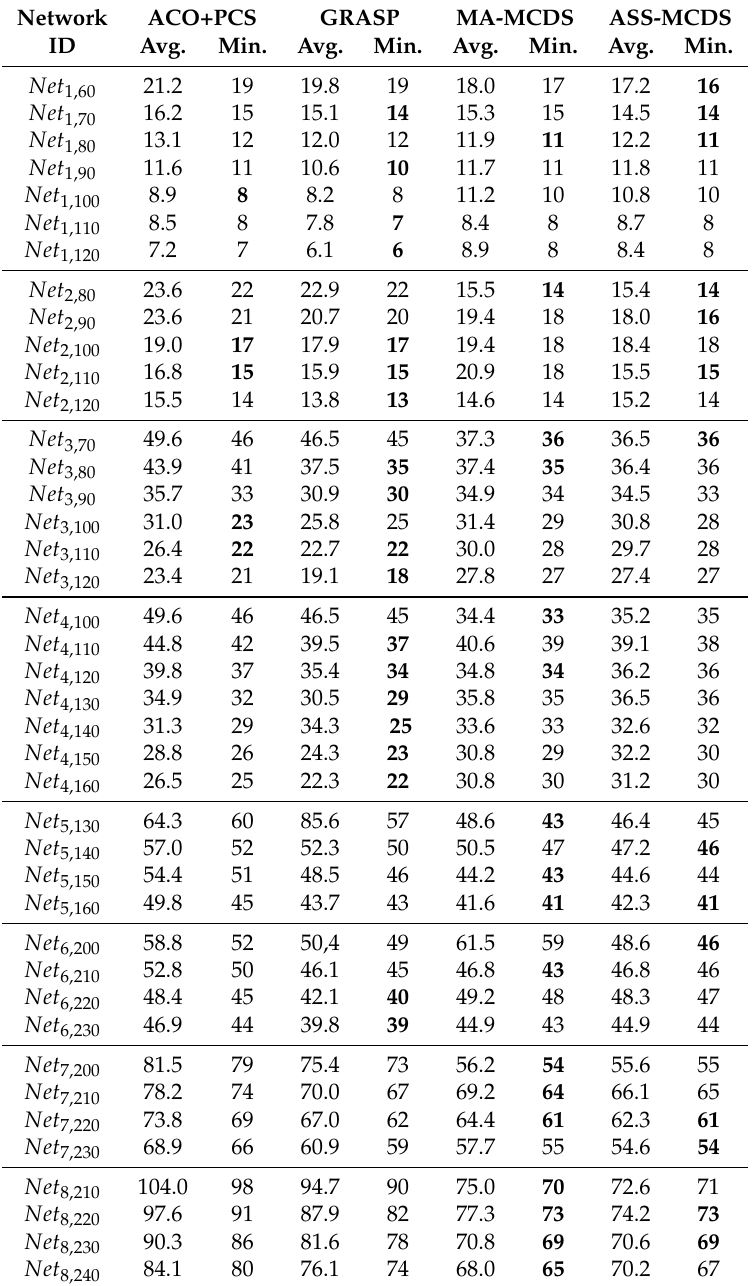
Table 3. Network clustering comparison